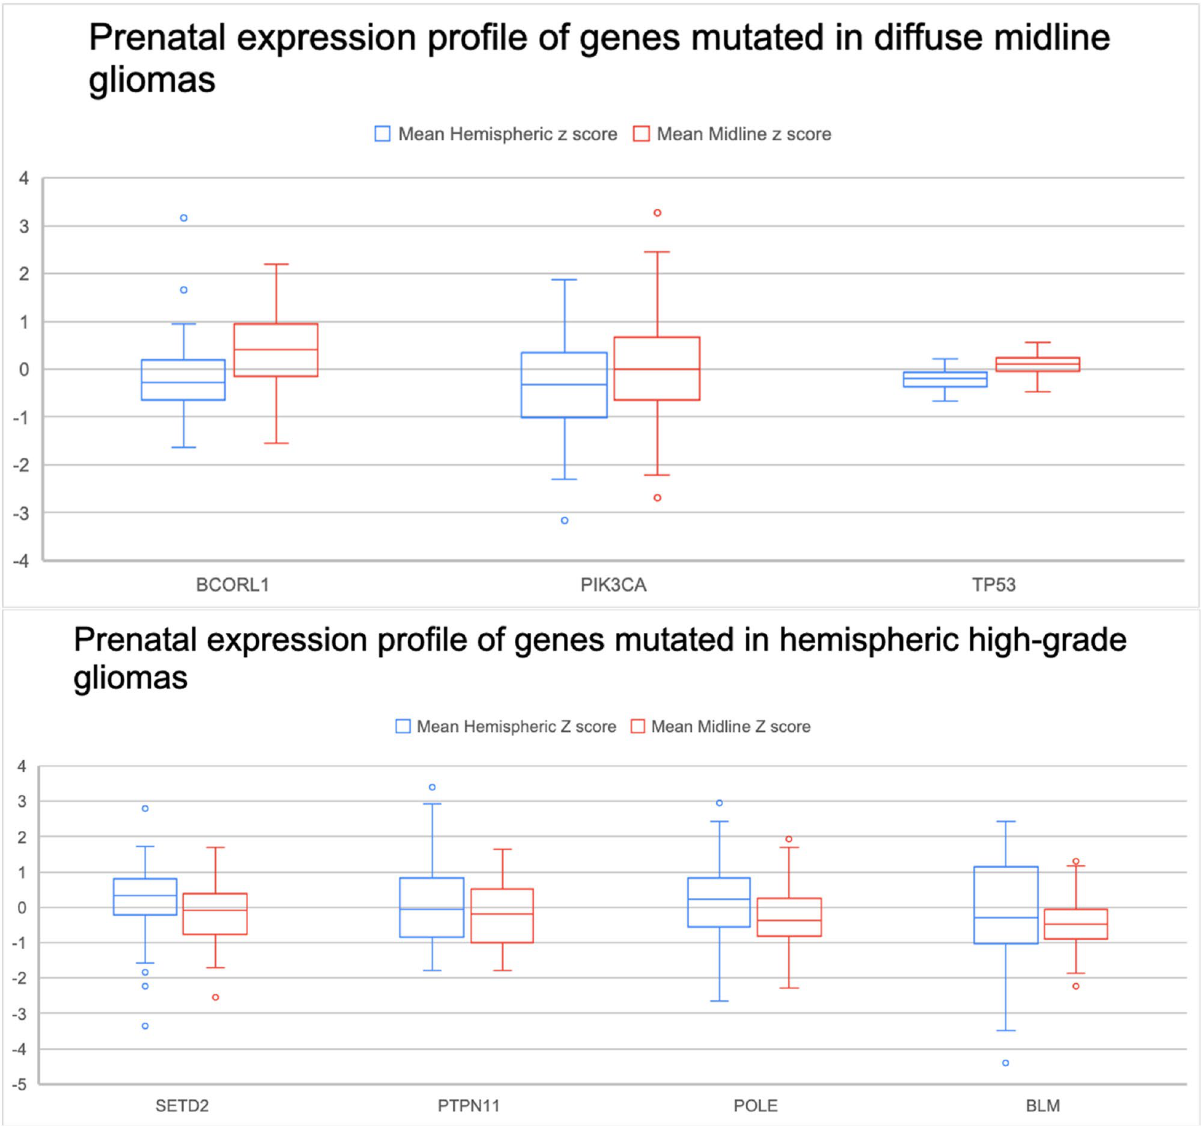
Figure 4. Gene expression patterns from prenatal brain atlas